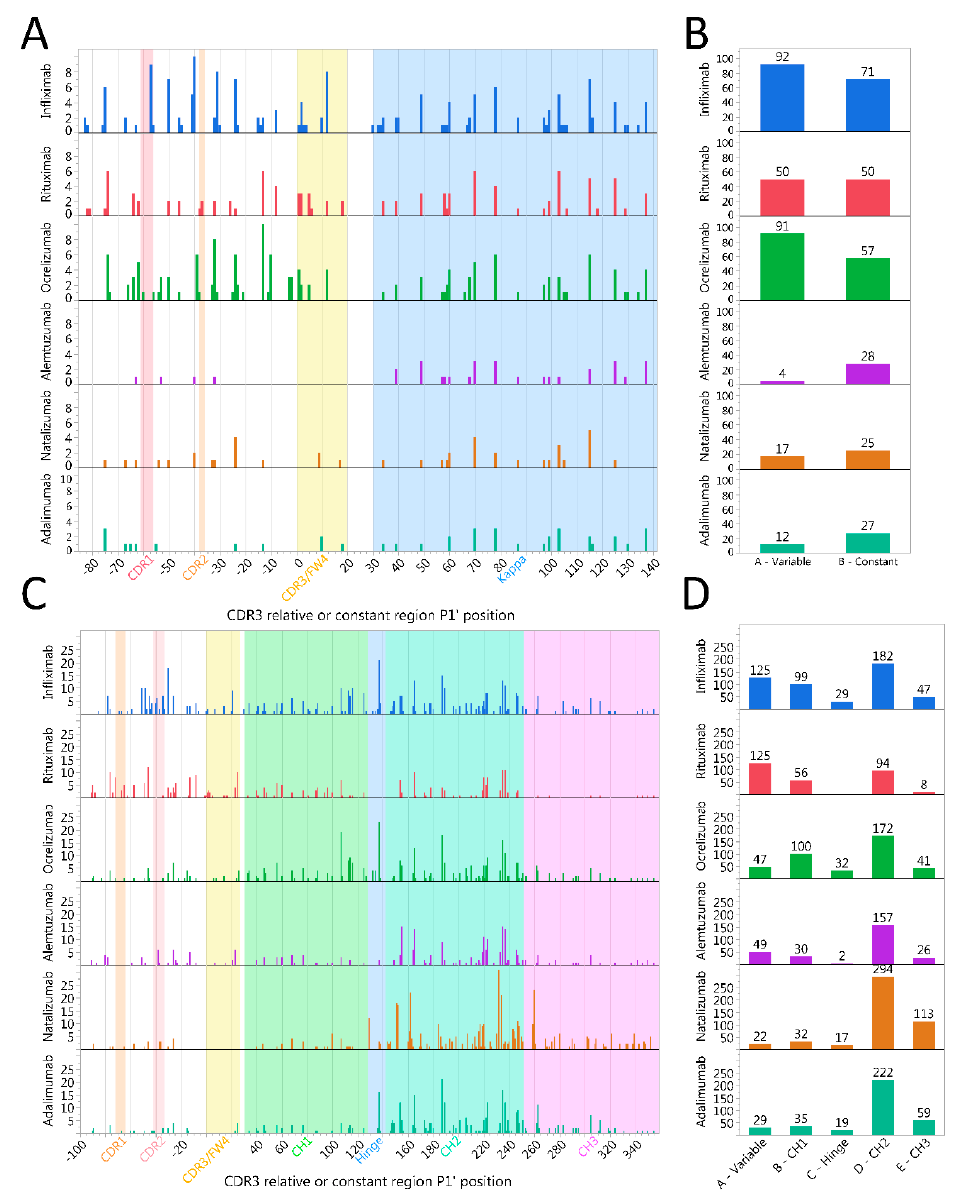
Figure 4. Observed pattern of cathepsin S cuts in monoclonal antibodies. The monoclonal antibodies adalimumab, alemtuzumab, infliximab, natalizumab, ocrelizumab, and infliximab were